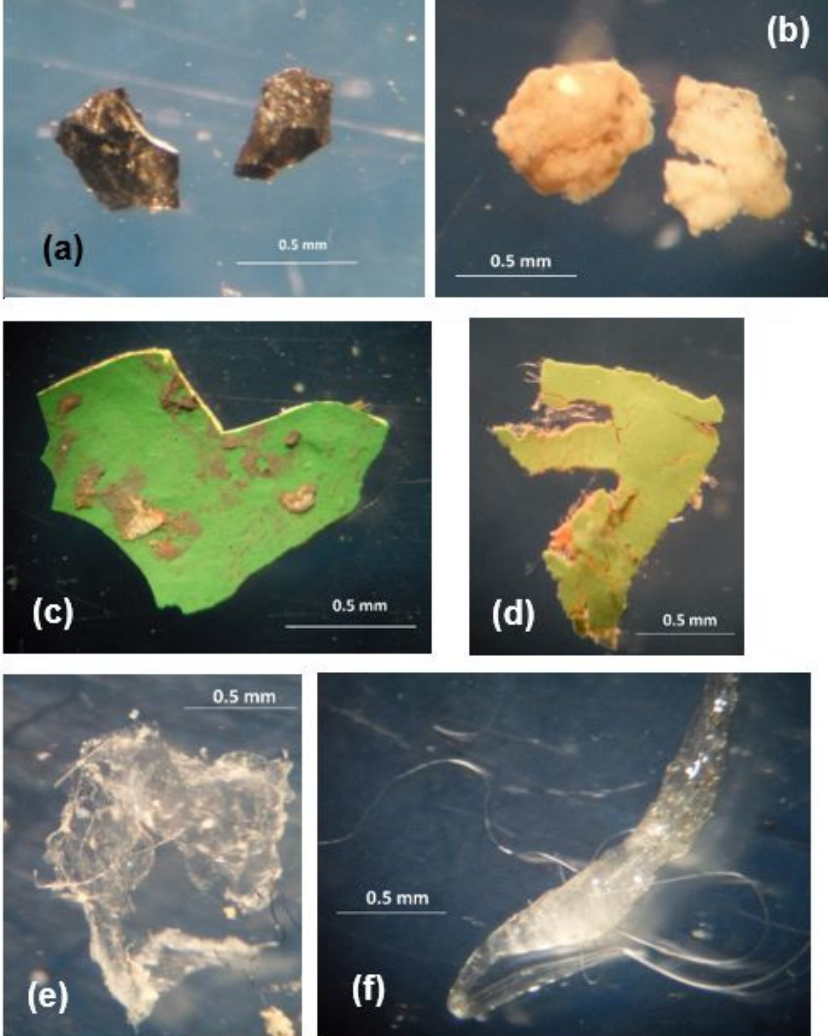
Figure 2. Photos of microplastic fragments that belong to the six morphotypes. ( a ) HR = ‘hard rounded’, ( b ) SR = ‘soft rounded’, ( c ) HF = ‘hard flattened’, ( d ) SF = ‘soft flattened’, ( e ) ML = ‘membrane like’, ( f ) CL = ‘cable like’. Description of these morphotypes is provided within the text.